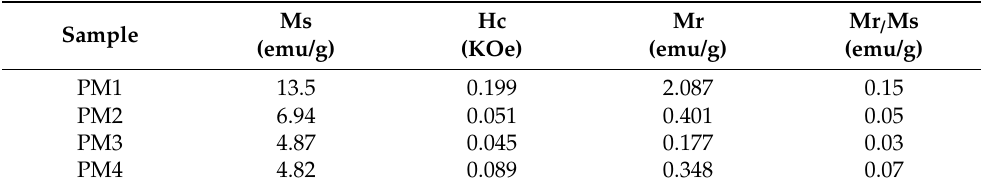
Figure 3. Magnetization curves of magnetic nanocomposites. Table 2. Magnetic properties of magnetic nanocomposites.